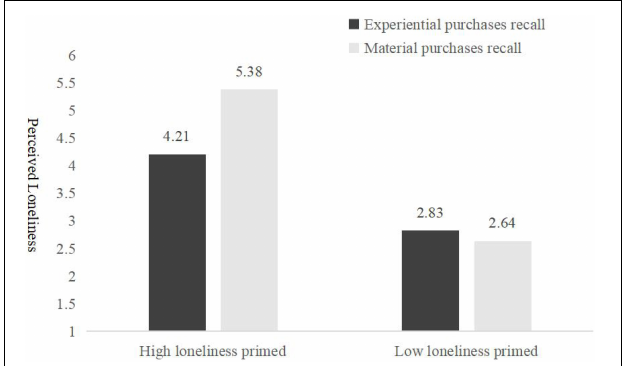
FIGURE 1 | Loneliness perception of experiential and material purchases recall (Experiment